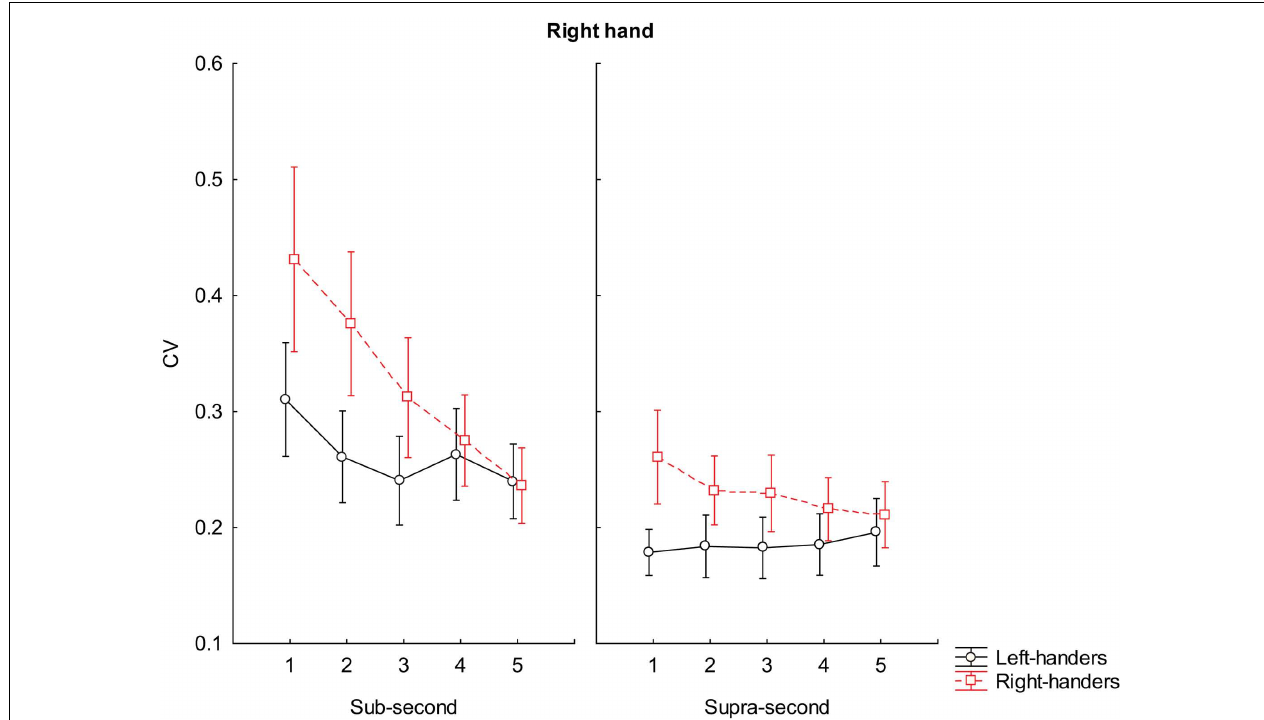
FIGURE 4 | Coefficient of variation scores during reproduction of sub-second and supra-second intervals with right hand. The vertical bars indicate SE mean.